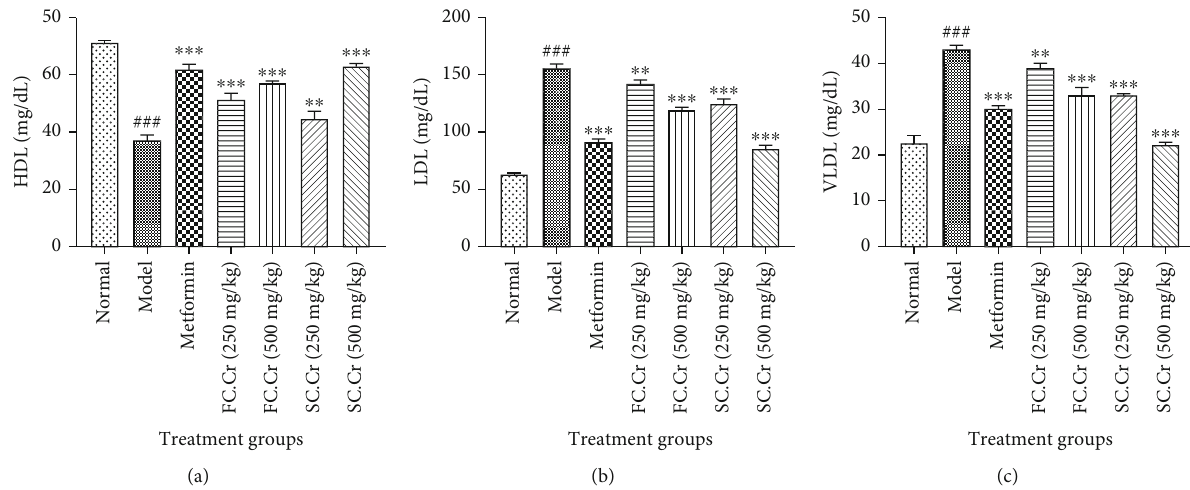
Figure 4: E ff ects of FC.Cr. and SC.Cr. on plasma levels of HDL (mg/dL), LDL (mg/dL), and VLDL (mg/dL) in HFD-STZ-induced rats. FC.Cr. and SC.Cr. were administered at 250mg/kg and 500mg/kg after three weeks till the end of study duration. HDL (a), LDL (b), and VLDL (c) were measured after drawing plasma from the treated and normal group of rats. The values are expressed as the mean of six animals in a group. Statistical analysis is performed with one-way ANOVA followed by Tukey ’ s test. All the groups are compared with the HFD-STZ group, while the HFD-STZ group is compared with the normal group. The results are considered signi fi cant ( ∗ ) if P < 0 : 05 and ( ∗∗ ) if P < 0 : 01 and highly signi fi cant ( ∗∗∗ ) if P < 0 : 001